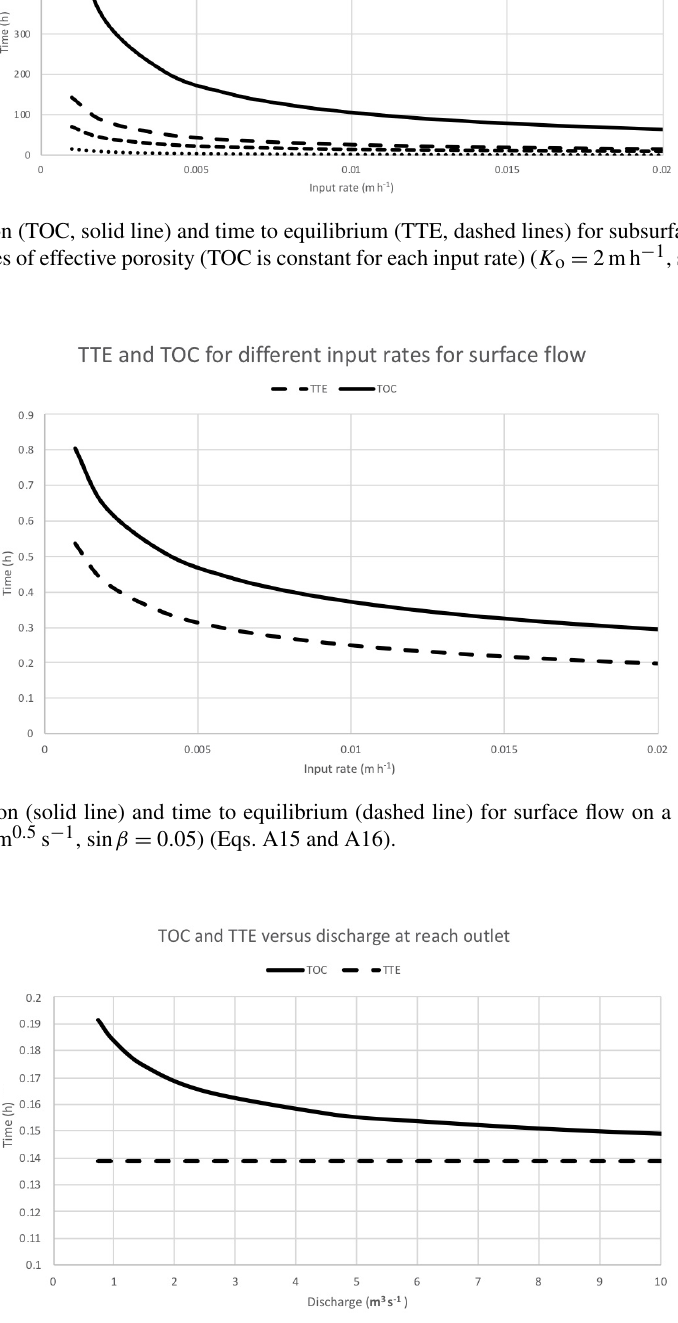
Figure A3. Time of concentration (solid line) and time to equilibrium (dashed line) for an upland channel reach of 500m, with parameters from Beven (1979a) ( a = 1ms − 1 ; k = 0 . 233m 3 s − 1 ). Upstream discharge 0.5m 3 s − 1 ; lateral inflows from 0.0005 to 0.02m 2 s − 1 (Eqs. A20 and